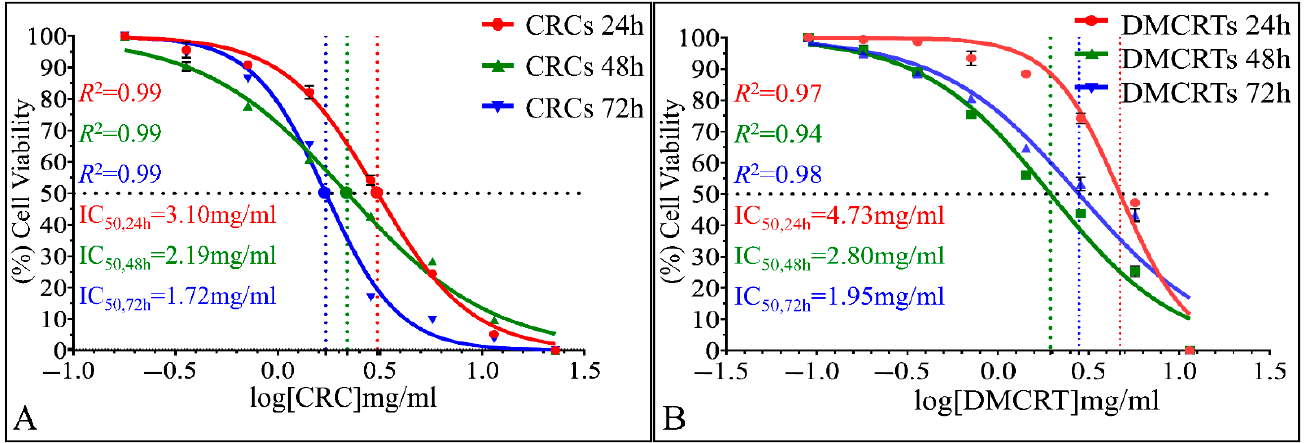
Figure 5. Calculation of IC 50 of CRCs and DMCRT on A172 cells. IC 50 were found 3.10 mg/mL ( R 2 = 0.99), 2.19 mg/mL ( R 2 = 0.99) and 1.72 mg/mL ( R 2 = 0.99), for CRCs, at 24, 48 and 72 h, respectively ( A ). IC 50 for DMCRT were estimated 4.73 mg/mL ( R 2 = 0.97), 2.80 mg/mL ( R 2 = 0.94) and 1.95 mg/mL ( R 2 = 0.98) at 24, 48 and 72 h, respectively ( B